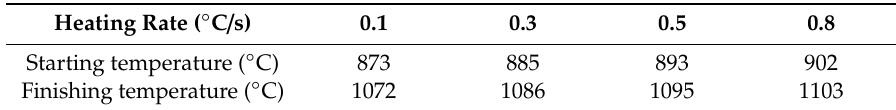
Figure 4. Dilatometric curves of Ti-6Al-4V at different heating rates of ( a ) 0.1 °C/s, ( b ) 0.3 °C/s, ( c ) 0.5 °C/s and ( d ) 0.8 °C/s. Table 1. The phase transformation temperatures with a non-linear change in the expansion amount at different heating rates.